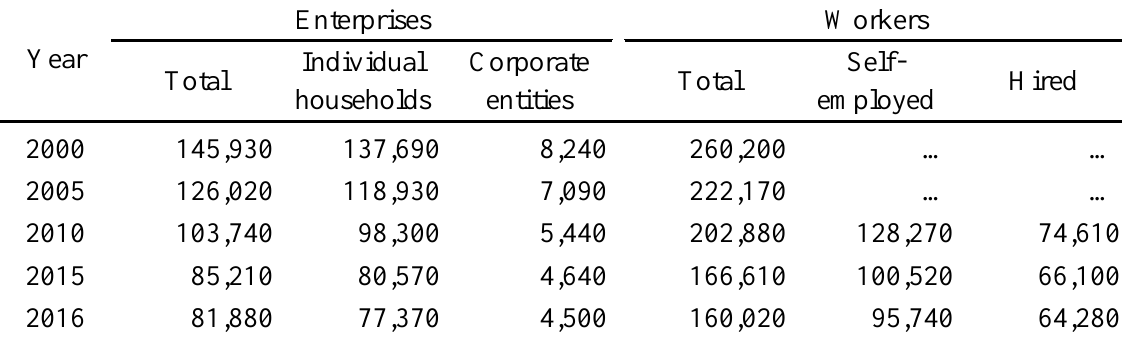
Table 5.7 Enterprises and Workers Engaged in the Marine Fishery/ Aquaculture